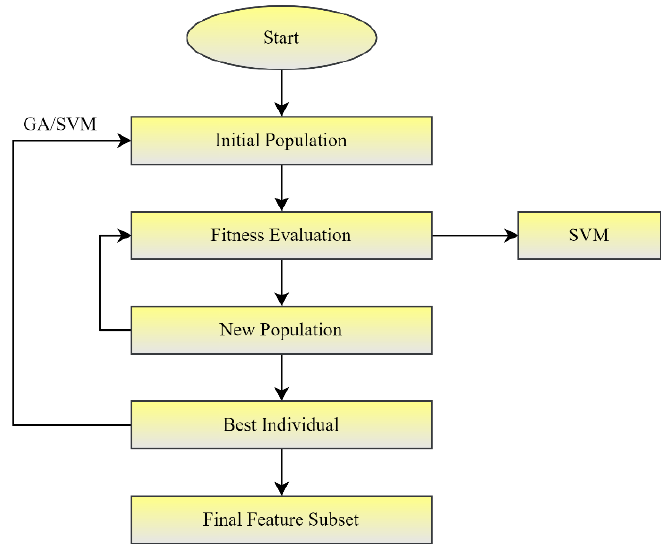
Figure 8. GA ‐ SVM Algorithm. Figure 8. GA-SVM Algorithm 2 shows the pseudocode for the GA ‐ SVM algorithm: Algorithm 2. The GA ‐ SVM pseudocode.